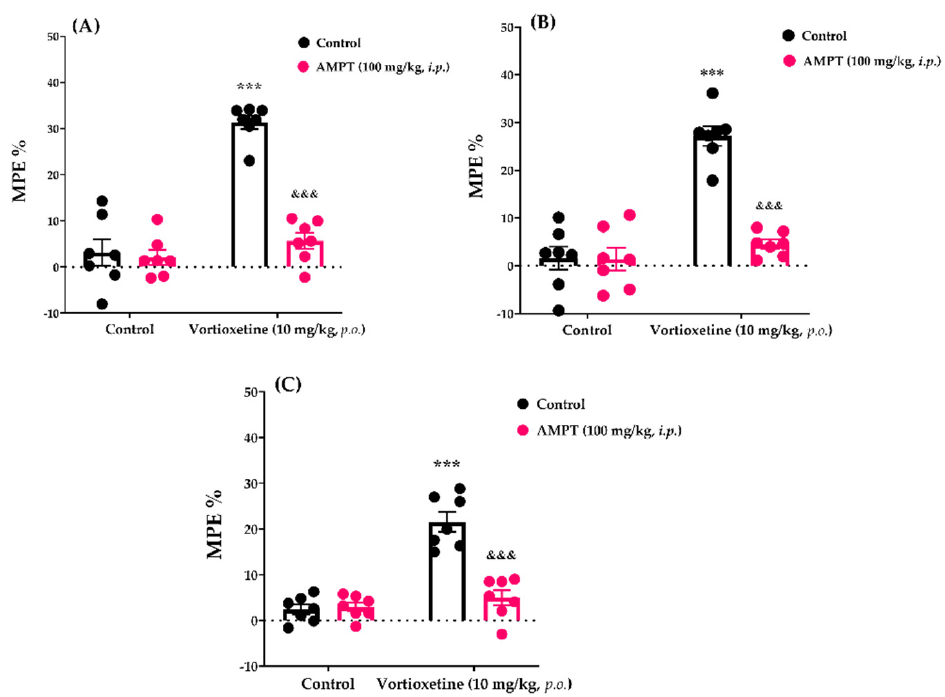
Figure 7. Involvement of catecholaminergic system in the analgesic effects of vortioxetine in the tail-clip ( A ), tail-immersion ( B ) and hot-plate ( C ) tests. Significant difference against vehicle treated control groups *** p < 0.001; Significant difference against vortioxetine administrated control groups &&& p < 0.001. Two-way ANOVA, post-hoc Bonferroni test, n = 7.